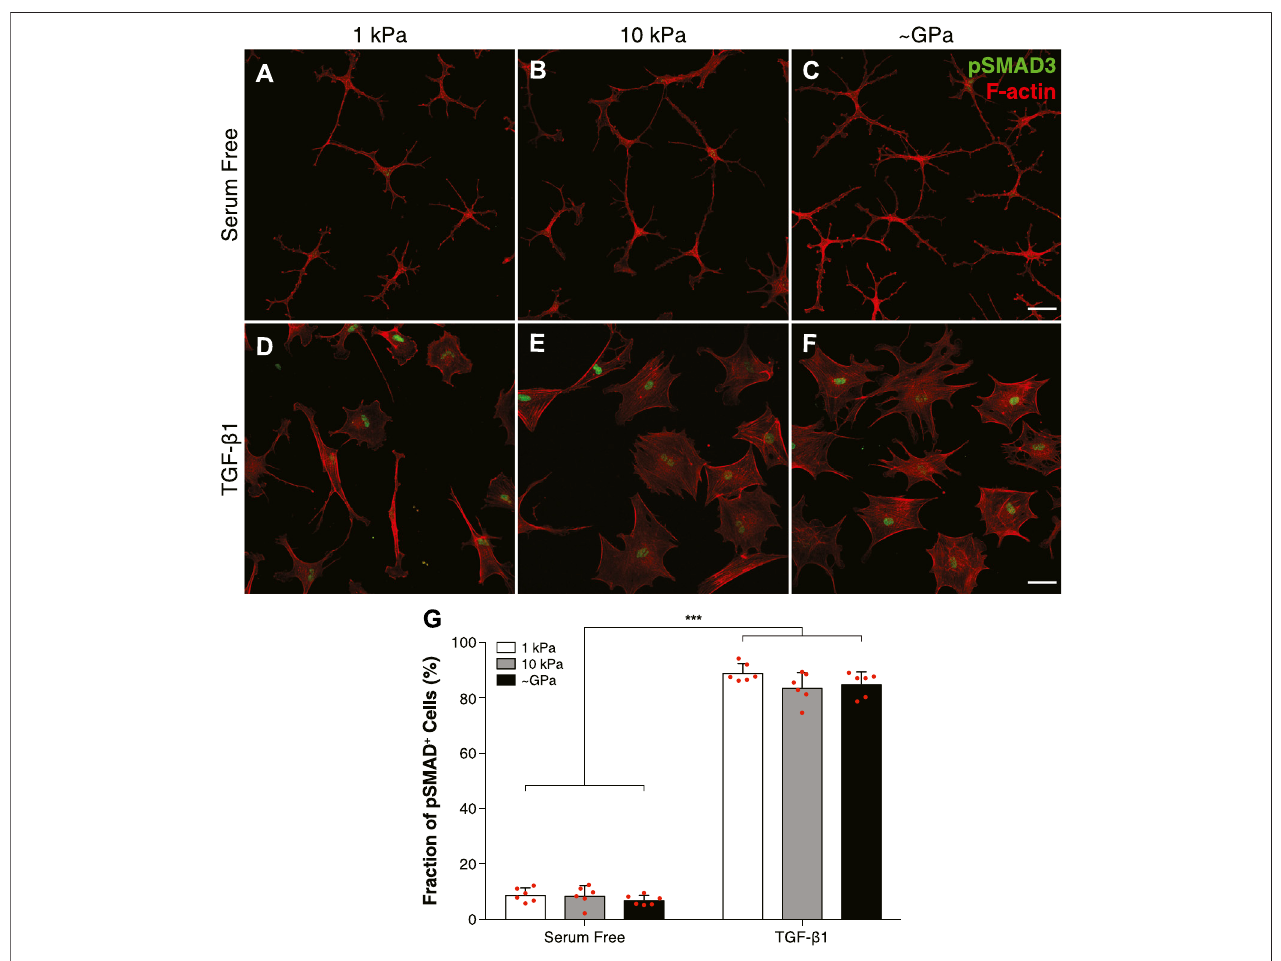
FIGURE 1 | TGF- β 1-mediated Smad activity is not regulated by substratum stiffness in cultured corneal keratocytes. (A – F) Characteristic confocal fl uorescence imagesofcells cultured oneitherfunctionalized1 kPa (A,D) or10 kPa (B,E) PAsubstrata, orcollagen-coatedglass (C,F) coverslips. Priorto fi xation,cellswerecultured in either serum-free conditions (A – C) or medium containing exogenous TGF- β 1 (D – F) for 5 days. Keratocytes were stained for both pSMAD3 immuno fl uorescence (green)andF-actin (red). (G) BarplotsshowingthepercentageofcellspositiveforpSMAD3staining.Errorbarsrepresentthemean±s.d.for n =6substratesfrom 3 experimental replicates. A two-way ANOVA with a Tukey post-hoc test was used to evaluate signi fi cance among groups. (***, p < 0.001). Scale bars, 50 μ m.